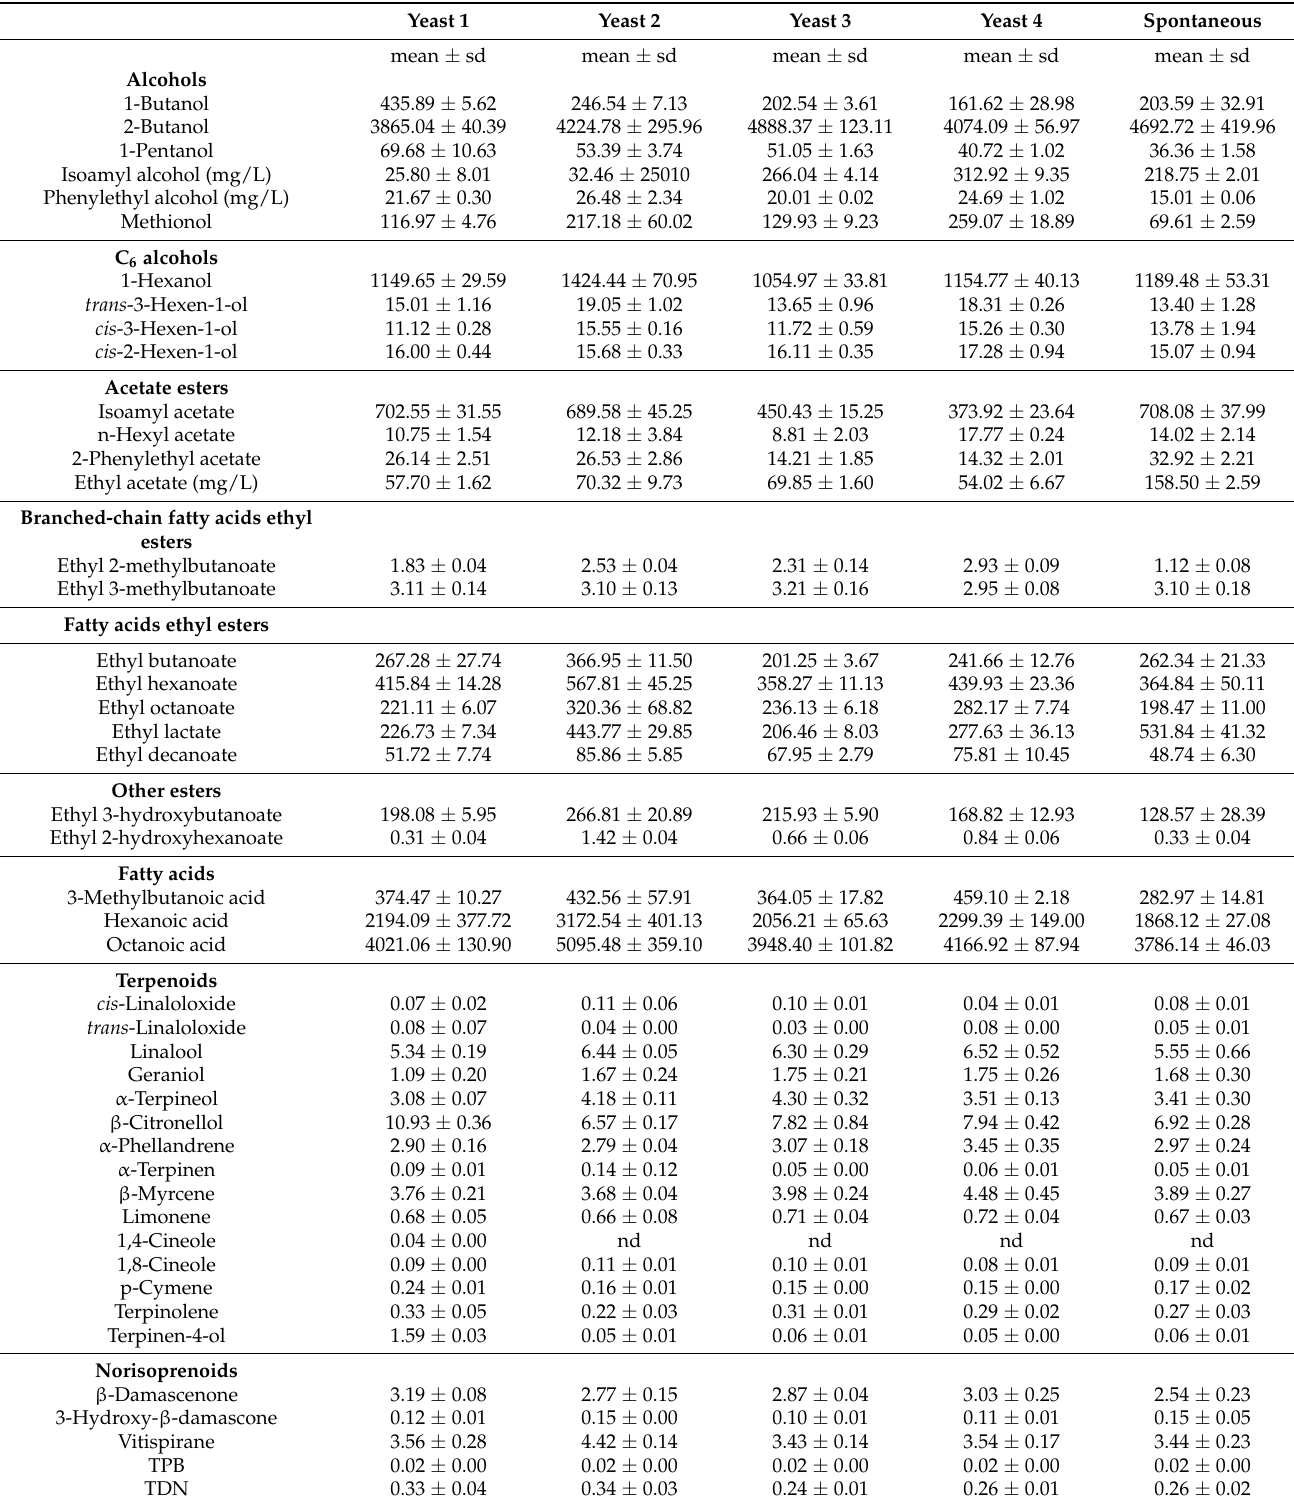
Table 6. Concentration ( µ g/L) of volatile compounds of Area 2 Corvinone